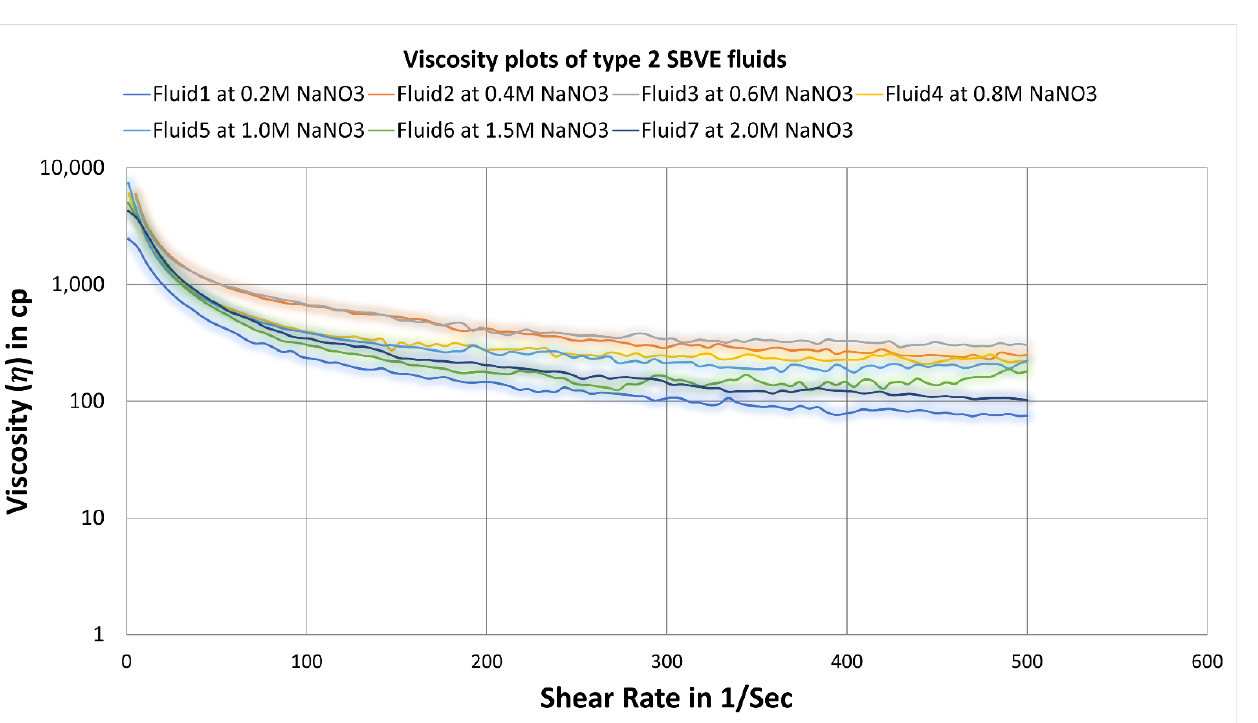
Figure 8. Comparison of viscosity plot of type2 viscoelastic fluids containing 0.6 M and 0.8 M NaNO 3 concentration at different temperatures.